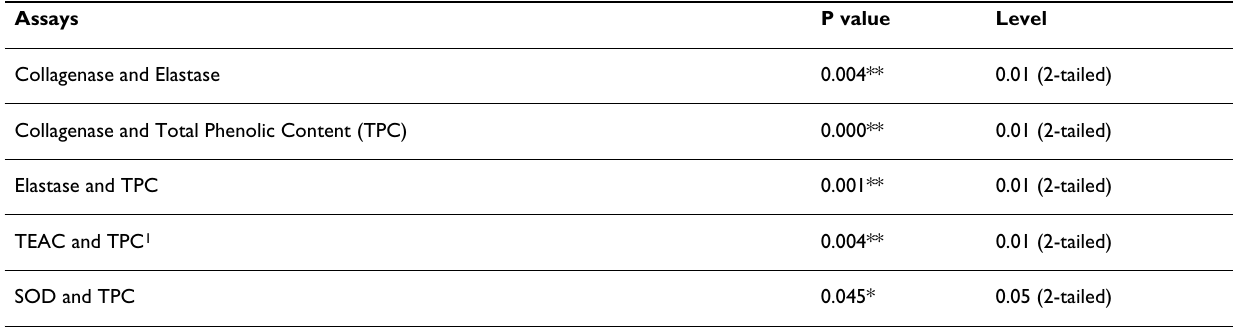
Table 2: Correlation analysis Results from Pearsons correlation test Assays P